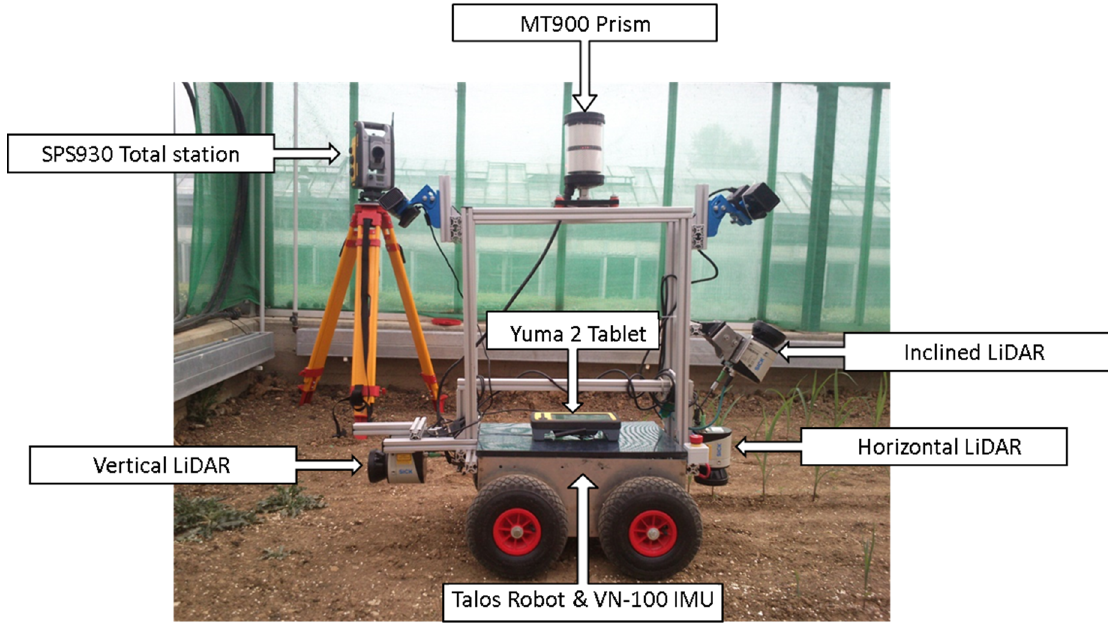
Figure 1. Equipment mounted on the “Talos” robot platform and the used total station.